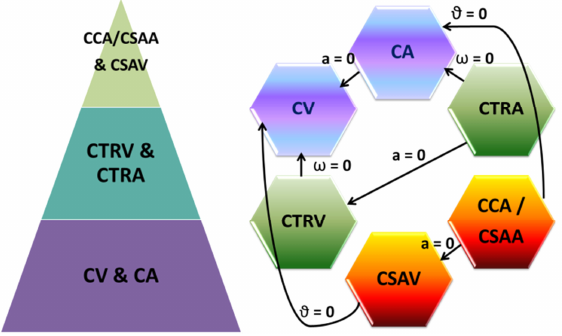
Figure 6. Scale of complexity of the motion models